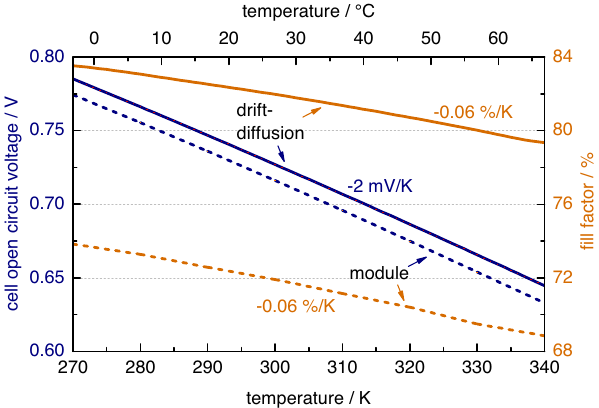
three simulation levels. The decreasing behavior of V oc and FF with rising temperature can be explained by the increasing intrinsic